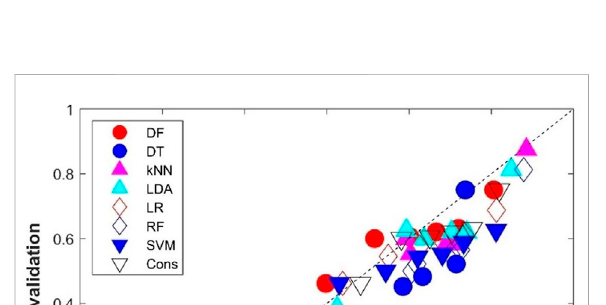
FIGURE 8 Prediction con fi dence analysis of the cross-validations. Prediction con fi dence levels are given at the x -axis. The accuracy of predictions at each con fi dence level is indicated by the y -axis. Performance metrics for the eight machine learning models are plotted in different shapes and colors given by the up-left corner